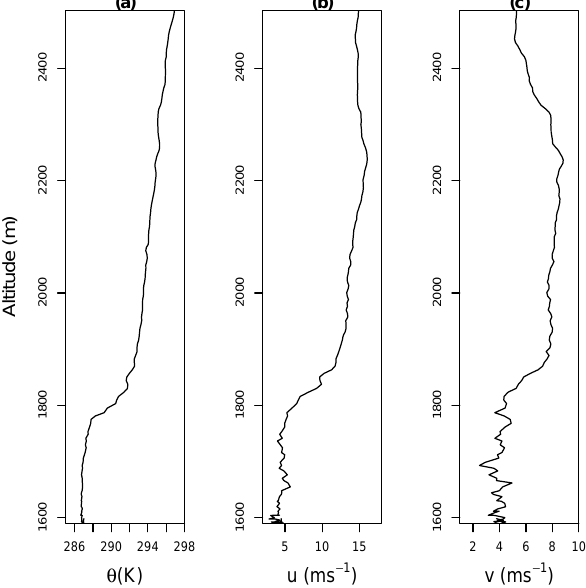
Fig. 2. Profiles of potential temperature (a) , horizontal wind speeds (b, c) sampled by the BAe 146.